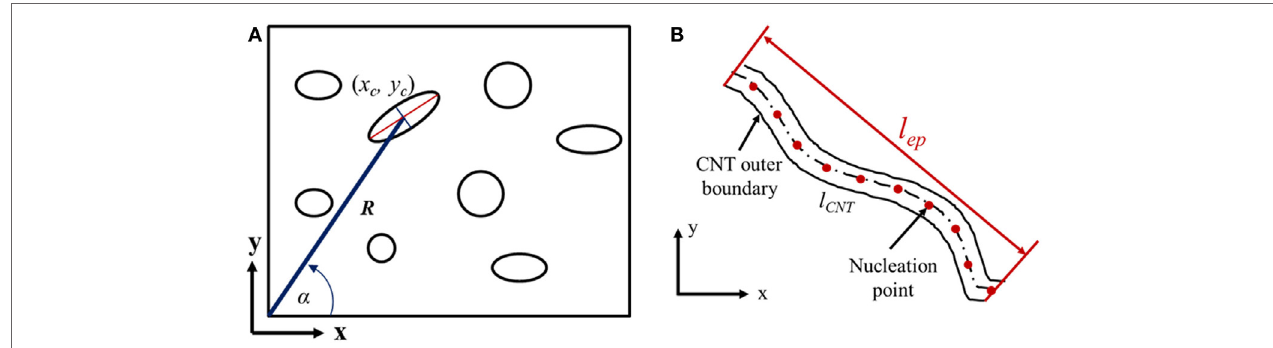
FigUre 2 | (a) CNT cross sections as extracted from SEM images using binary conversion to determine spatial distribution; (B) schematic of a wavy CNT with the definition of measured parameters used to determine CNT waviness (Bhuiyan et al.,